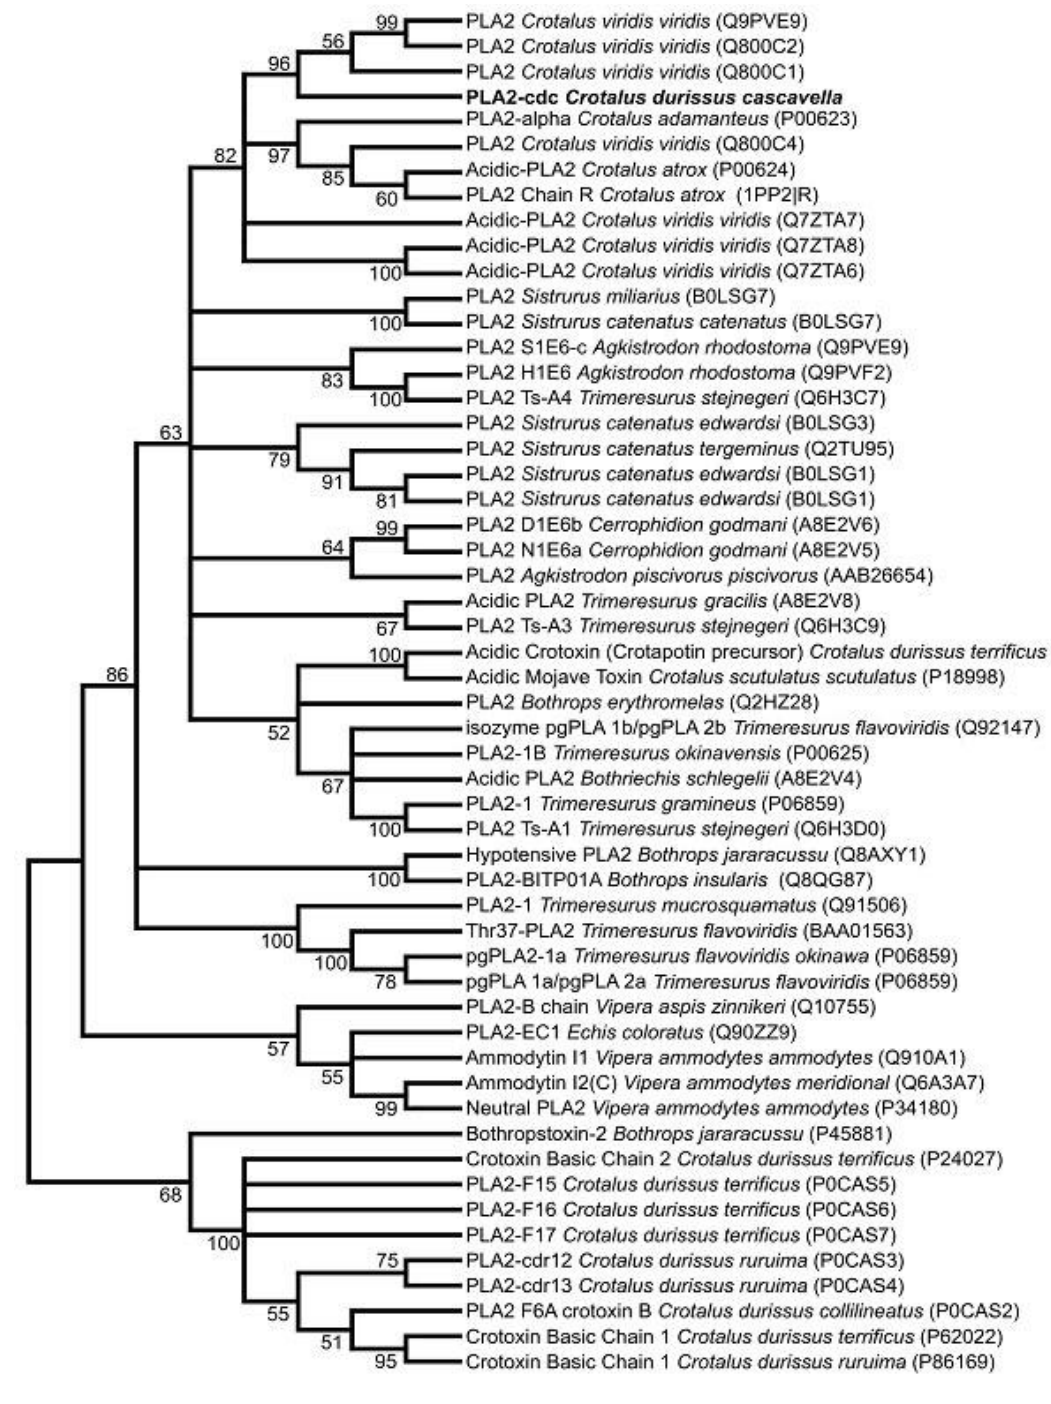
Figure 2. Evolutionary relationship of Cdc-PLA evolutionary history was inferred using the neighbor-joining method. The optimized tree is shown. The percentage of replicate trees in which the associated taxa were clustered together in the bootstrap test (50% cutoff) is presented next to the branches. The tree is drawn to scale, with branch lengths in the same units as